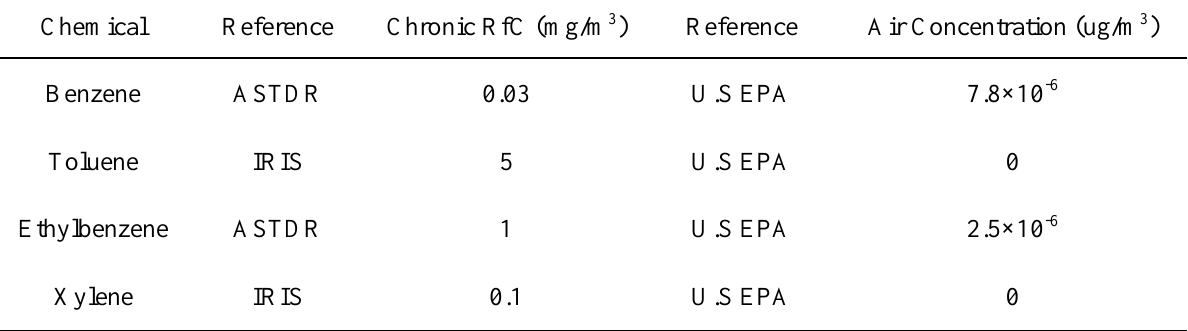
Table 2. Reference Dose for BTEX